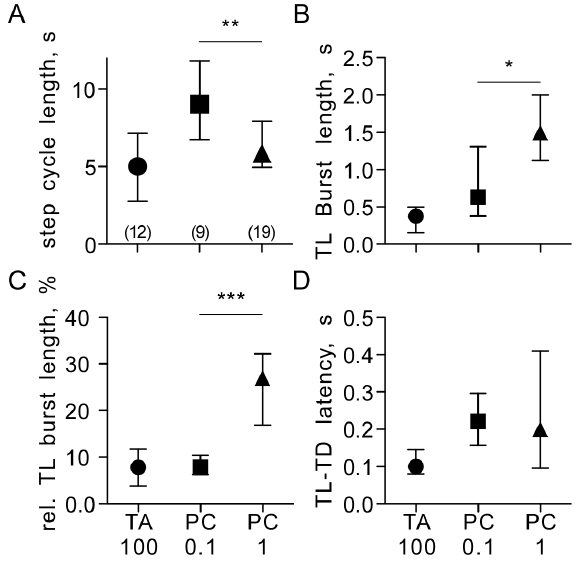
Figure 5. Charts comparing key features of fictive walking patterns released by tyramine (TA, circles: 100 mM) and by a low and higher concentration of pilocarpine (PC, squares: 0.1 mM, triangles: 1 mM). A Step cycle length, B TL burst length, C relative TL burst length (as % of step cycle length), D TL-TD latency. Symbols give the median, ticks the interquartile range and asterisks significant differences between indicated groups (Mann Whitney U test for unpaired data sets *p , 0.05, **p , 0.01, ***p , 0.001). Numbers in parenthesis (chart A) give the number of preparations for each test